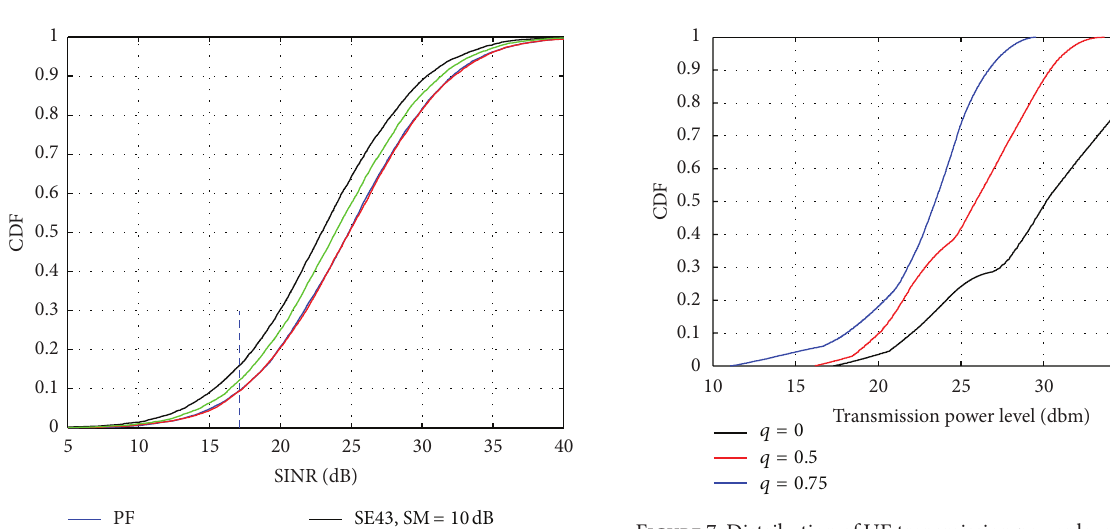
Figure 7: Distribution of UE transmission power levels for different fractions 𝑞 of interference margin allocated for BS transmissions. The simplified PF power allocation rule supporting mobility within groups of pixels (13) is utilized. The protection distance is 10